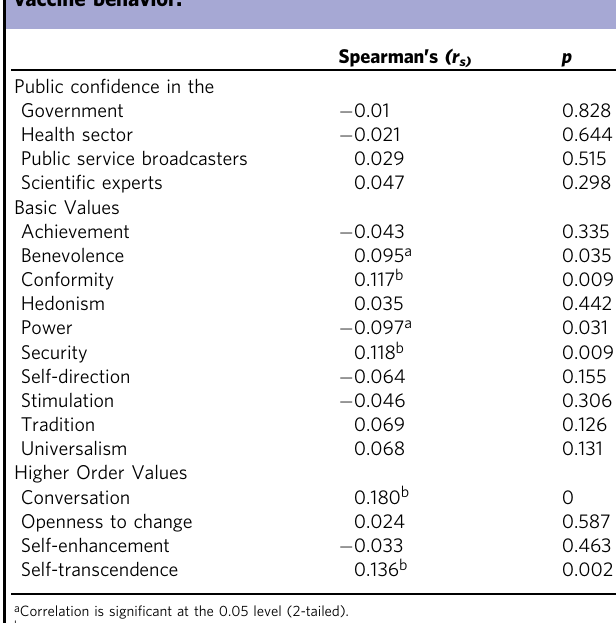
Table 2 Relationship between social value orientation and vaccine